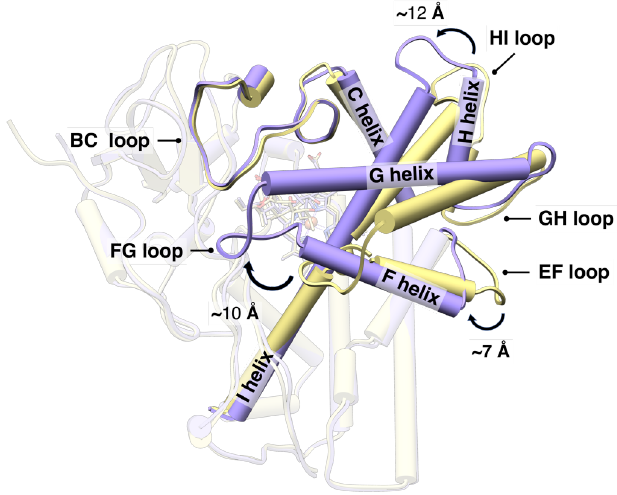
Figure 1. Conformational change of the substrate-bound OleP. Top view of the open (yellow) and closed (purple) structures of OleP-6DEB (6-deoxyerythronolide B, abbreviated in 6DEB) complex (pdb id 5MNV and 5MNS, respectively [5]) superposed. The secondary structure elements mainly involved in the conformational change are labelled and highlighted. Helices are represented as cylinders. Arrows indicate the direction of the open-to-closed transition. The 6DEB and heme are represented in transparency as